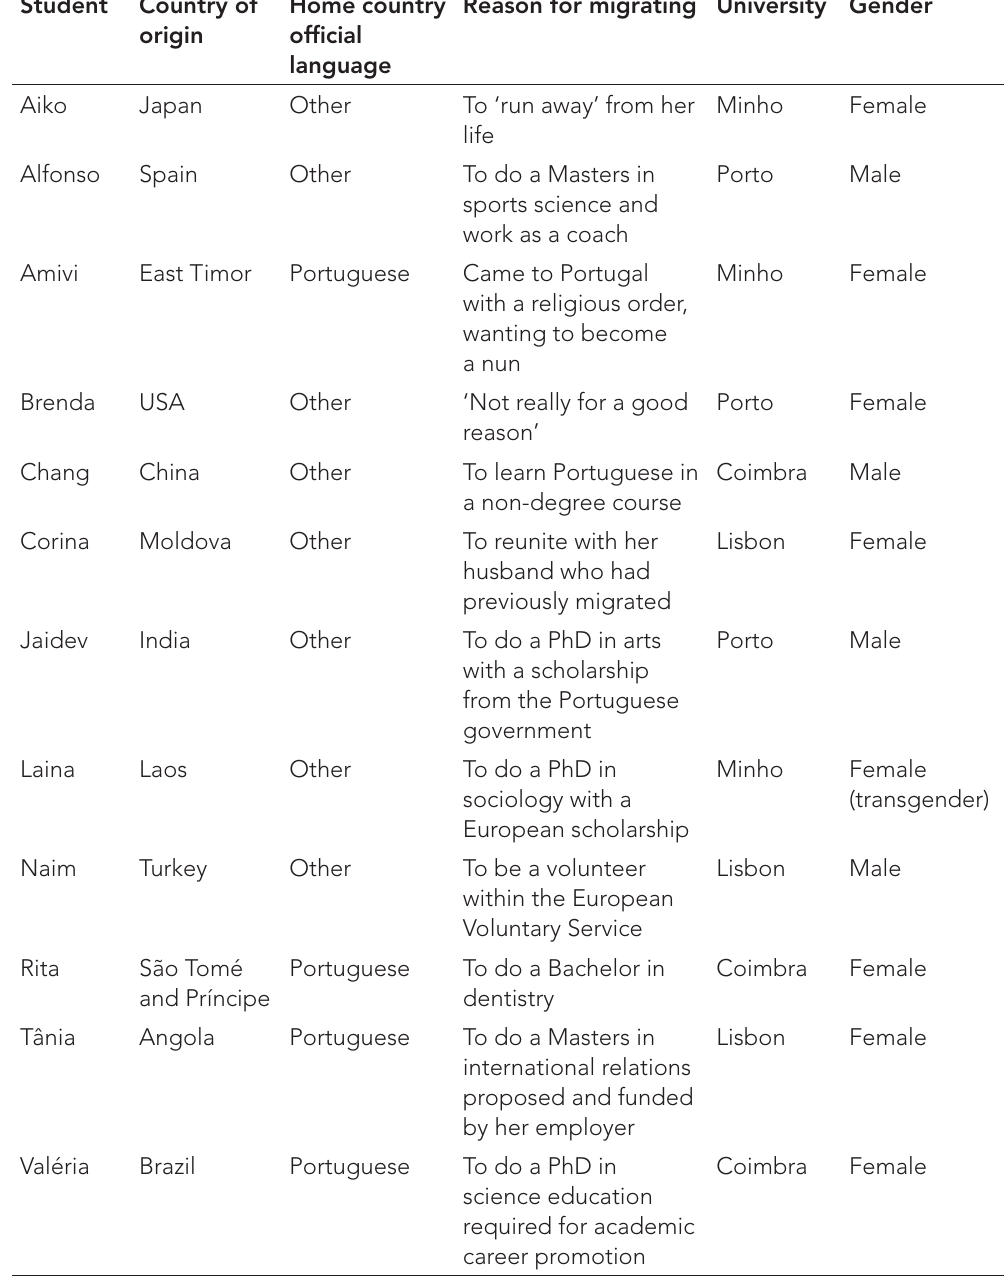
Table 1: Description of the 12 research